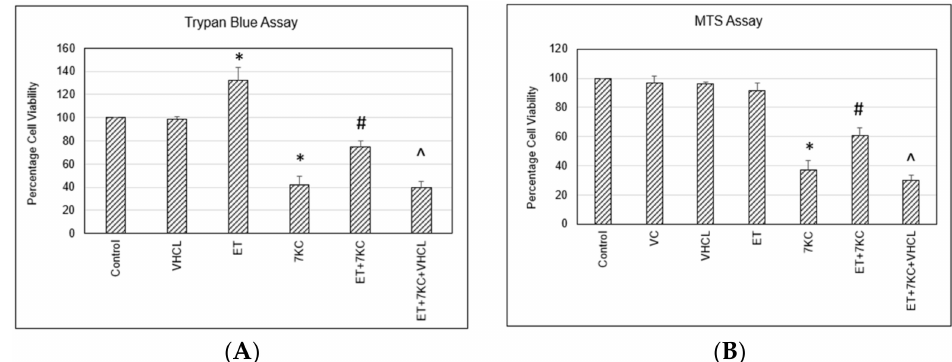
Figure 1. Cell death and cell viability assays. Treatment of cells with 30 µ M 7KC resulted in death of brain endothelial cells using Trypan blue assay, and cell loss was significantly decreased by cotreatment with ET. ET alone increased cell viability using Trypan blue assay but not with MTS assay. ( A ) The protective effect of ET was abolished when the cells were treated with an inhibitor of OCTN1 and VHCL, together with ET. Comparable results were obtained using MTS assay. ( B ) ET was found to block 7KC-induced injury in this assay, and the effect was abolished when the cells were incubated with VHCL. VC: Vehicle control; ET: 1 mM ET; VHCL: 100 µ M VHCL; 7KC: 30 µ M 7KC. Data are represented as the mean ± SD (n = 4). * Significant difference compared to controls ( p < 0.05). # Significant difference compared to 7KC. ˆ Significant difference compared to ET + 7KC. Data were analysed by one-way ANOVA with Bonferroni’s multiple comparison post-hoc test.